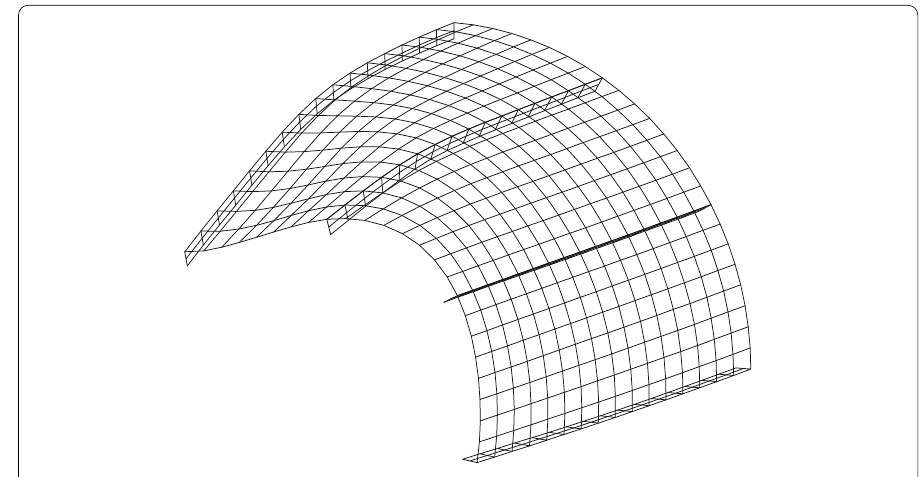
Fig. 41 Final deformed configuration computed with a 24 × 16 × 2 mesh